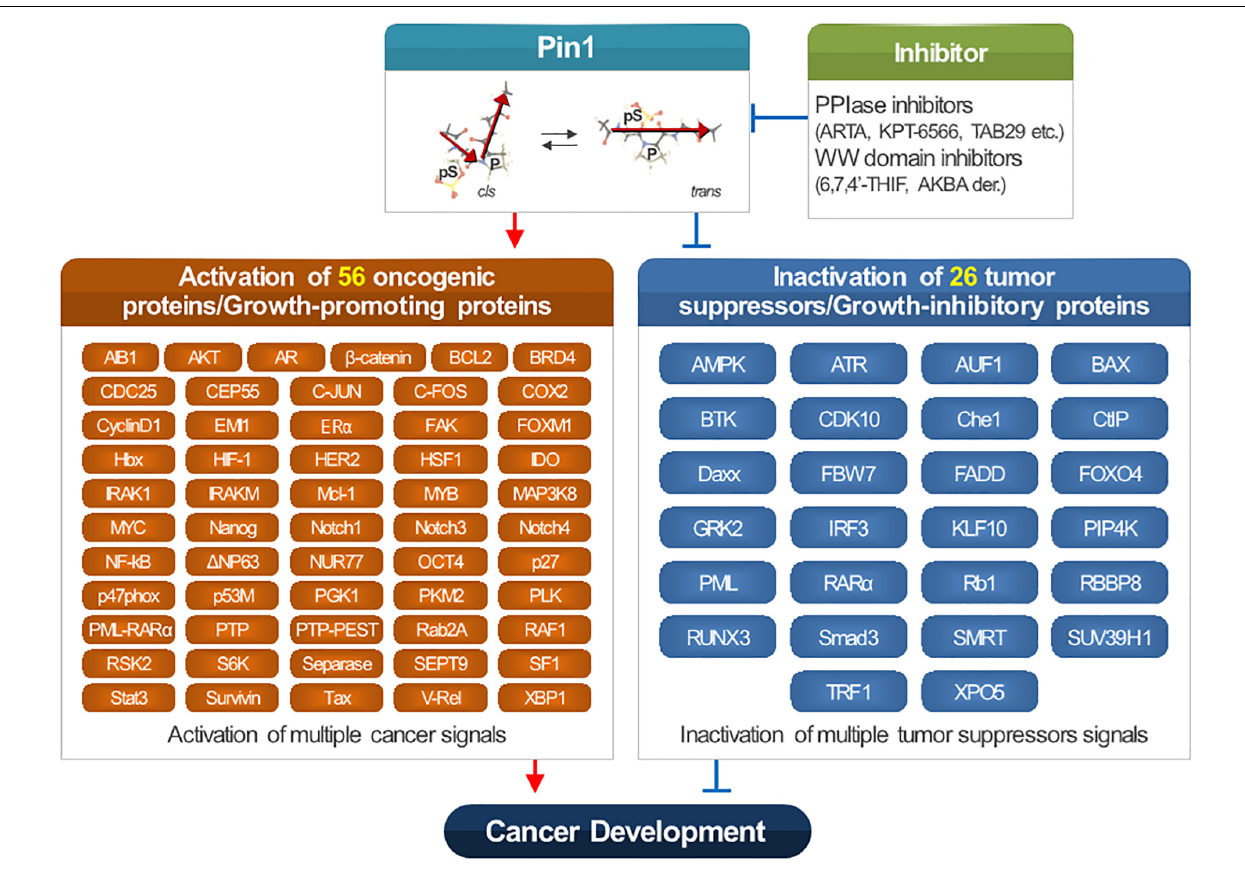
FIGURE 1 | Function of PIN1 in cancer